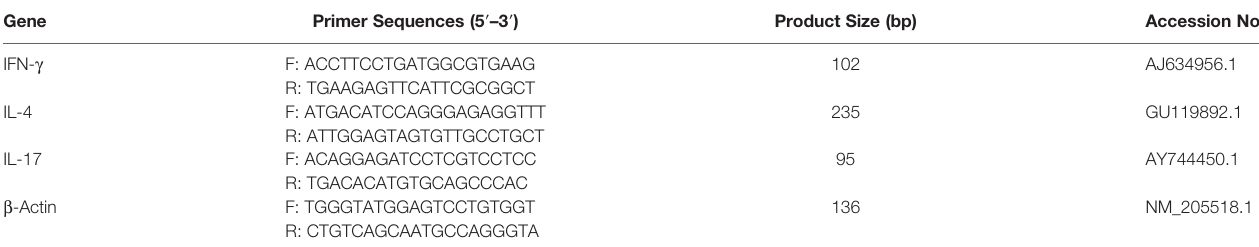
TABLE 2 | Sequences of primers used for quantitative real-time PCR.